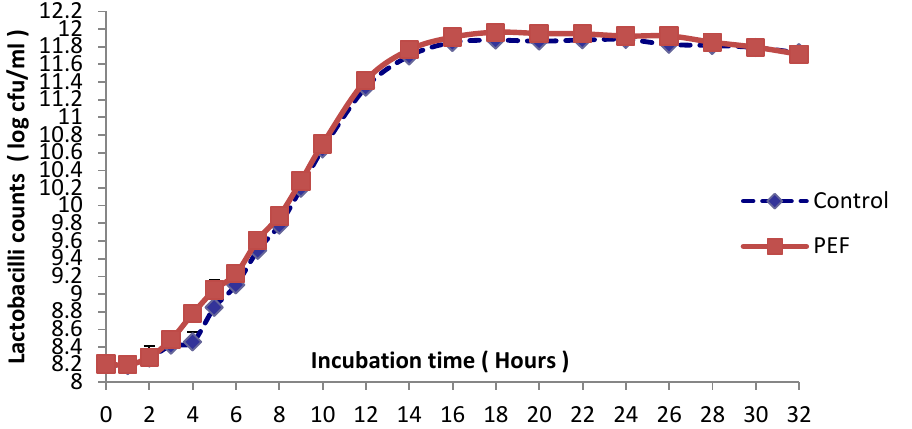
Figure, 2: The influence of mild pulsed electric field conditions on the growth characteristics of Lactobacillus acidophilus LA-K . Mean square (MS) and Pr > F of mild PEF treatment, hour, and their interaction for growth, bile tolerance and protease activity of Lactobacillus acidophilus LA-K. Source Growth Bile tolerance Protease activity